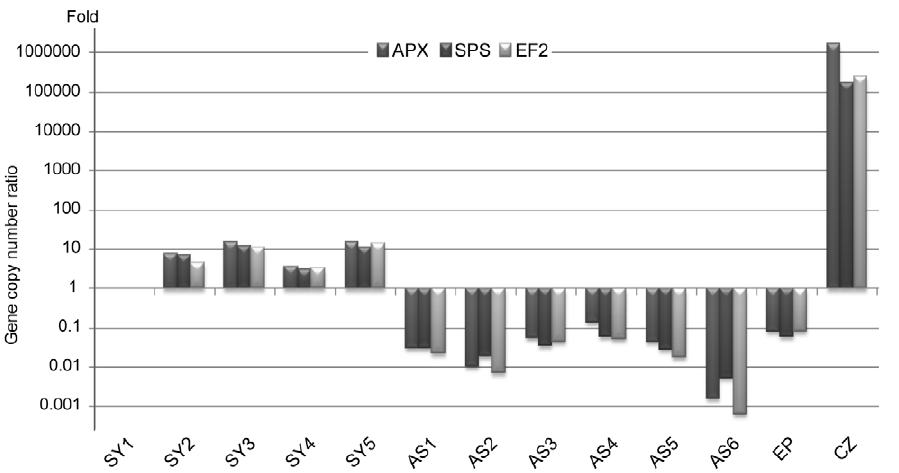
Figure 1. Symbiodinium quantification by real-time quantitative PCR (symbiont to host nuclei ratio). Symbiodinium nuclear EF2, SPS, APX and A. viridis nuclear COP- c gene copy numbers were assessed by qPCR performed on total genomic DNA extracts from 5 symbiotic anemones (Sy1–Sy5), 6 aposymbiotic anemones (AS1–AS6), in vitro cultured Symbiodinium (CZ) and epidermal tissue fraction (Ep). The histogram represents the relative copy number ratios of EF2, SPS and APX to COP- c , relative to the Sy1 sea anemone, expressed in fold number.